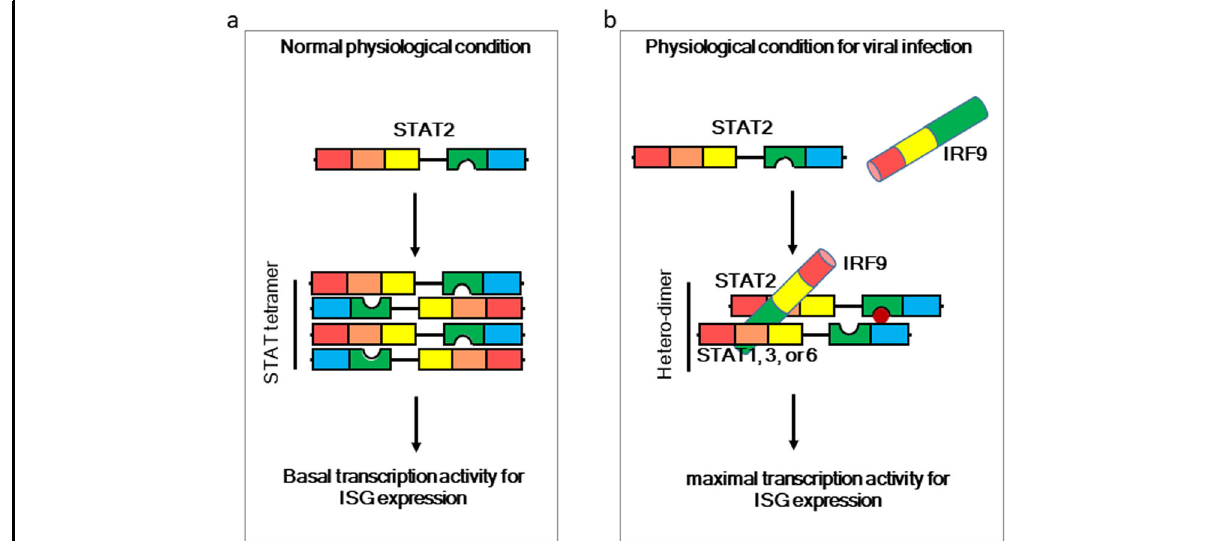
Fig. 2 Representative regulatory mechanisms of STAT2-mediated ISG expression. a ISG expression under normal physiological conditions. Without stimulation, STAT2 forms a tetramer complex with other STAT family members, including STAT1, 3, and 6, through their N-terminal domains, resulting in an anti-parallel structure. The complex induces basal expression of target genes. b ISG expression under physiological conditions after viral infection. When cells are infected with viruses, activated JAK1- and TYK2-mediated phosphorylation of STAT2 at tyrosine residues triggers the formation of a SH2 – pTyr interaction-mediated homo- or heterodimer complex, which associates with IRF9 and results in the formation of the ISGF3 complex. The ISGF3 complex plays a key role in target gene expression in response to viral